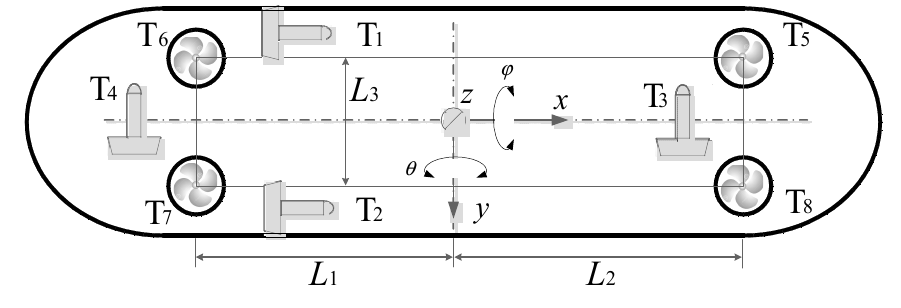
Figure 7. Thruster configuration of UVIC-I AUV.